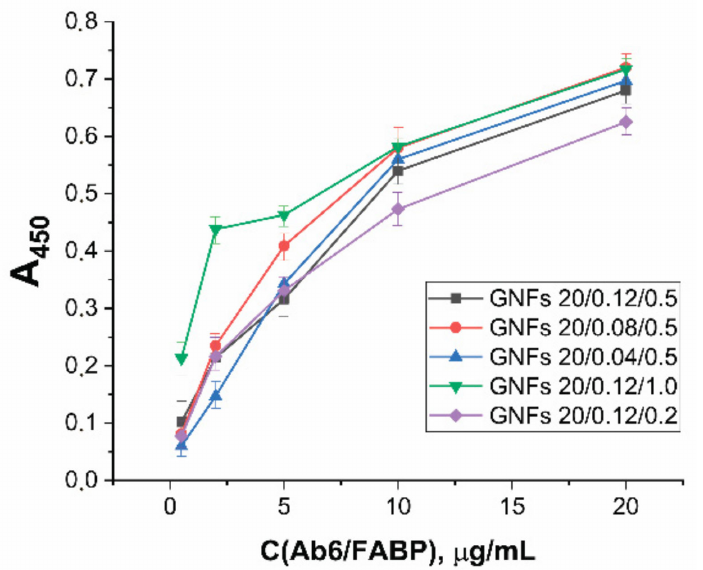
Figure 6. Dependence of optical density in ELISA tests of functional activities for GNFs–Ab6/FABP conjugates on Ab6/FABP concentration during conjugates syntheses for different